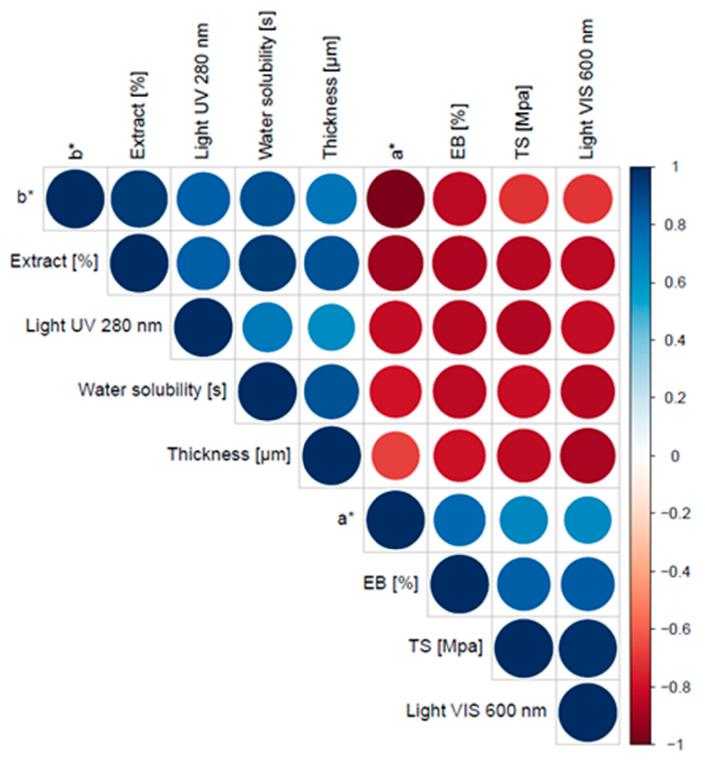
Figure 4. Spearman rank correlation plot based on films’ physical and mechanical profiling. a * and b * are parameters of color (Section 2.4.2.).